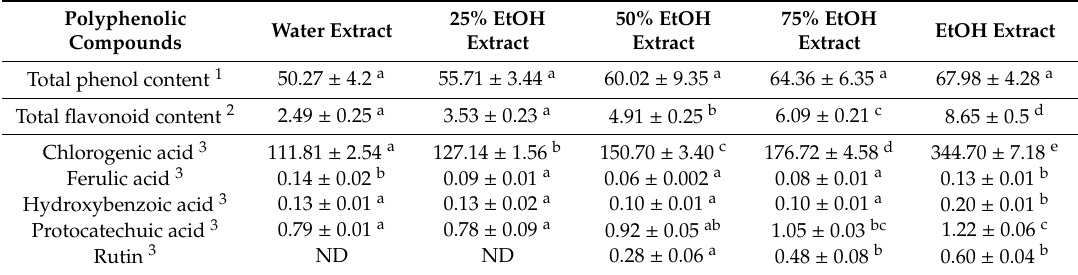
Table 1. E ff ect of ethanol concentration on polyphenolic compound extraction from Sorbus commixta